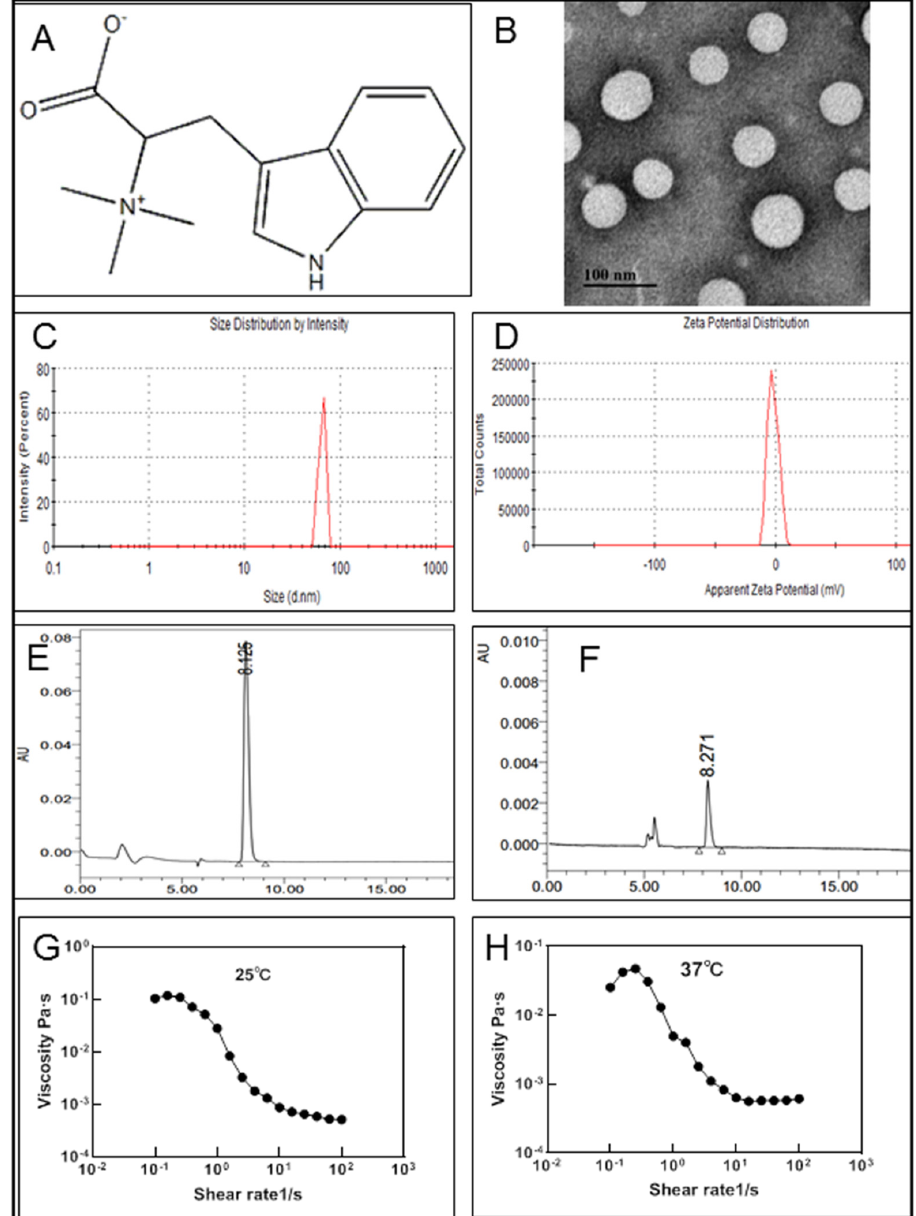
Figure 1. Physicochemical characteristics of HYP-NPS . ( A ). Molecular structure of hypaphorine. ( B ). TEM of HYP-NPS. ( C , D ). Particle size distribution data and zeta potential of HYP-NPS. ( E ) HPLC detection of hypaphorine. ( F ). HPLC detection after centrifugation. ( G , H ) Viscosity properties of HYP-NPS hydrogels under 25 ◦ C ( G ) and 37 ◦ C ( H ) ( n =